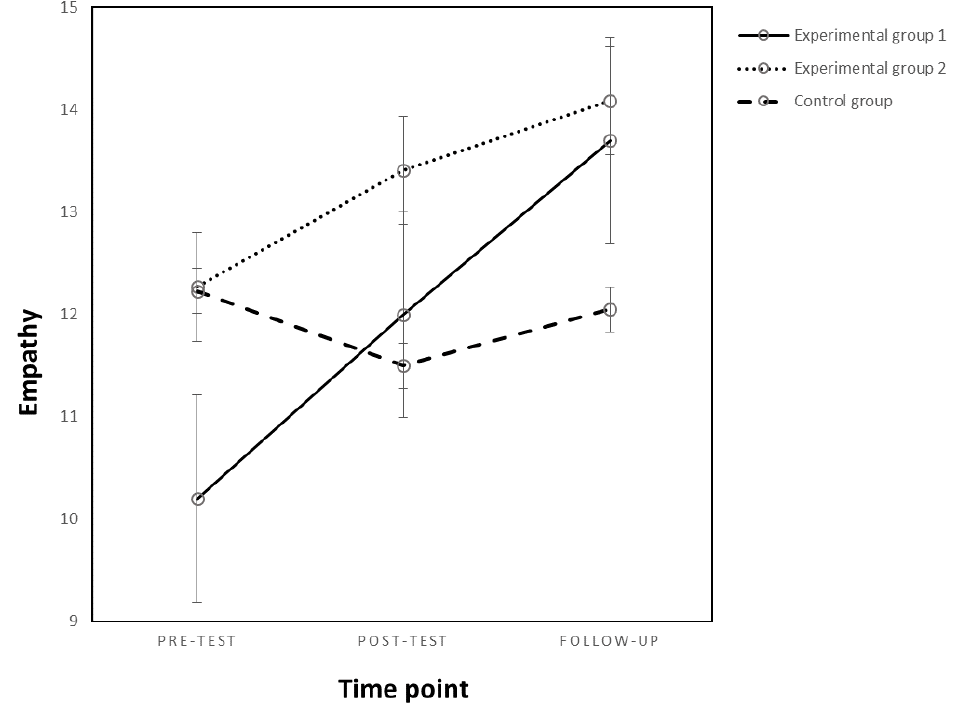
Figure 1. Changes in empathy as an effect of the experimental condition and time point.